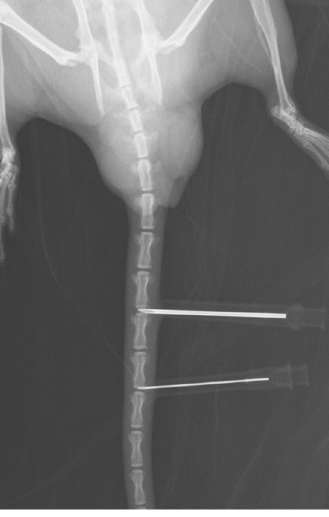
Figure 5. A radiograph demonstrating two needles puncturing Co6-7 and Co8-9 discs.